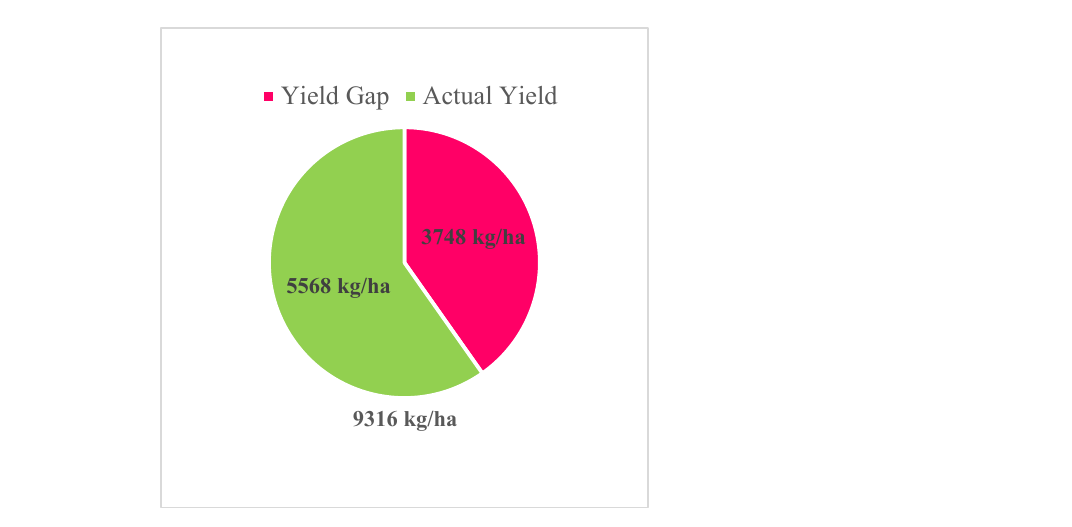
Figure 7. Potential yield, actual yield, and yield gap for the investigated area of Varamin plain in brief.